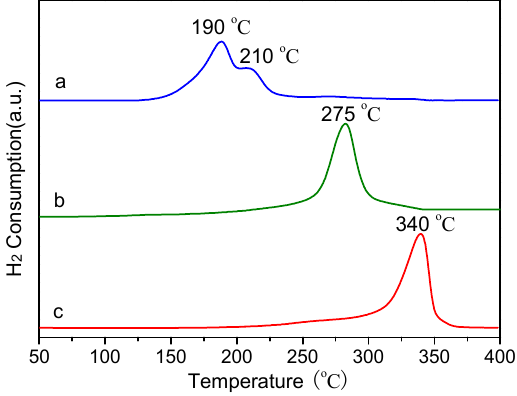
Figure 7. H 2 temperature ‐ programmed reduction (H 2 ‐ TPR) profiles of ( a ) Cu 2 O ‐ NO 3 , ( b ) Cu 2 O ‐ Cl(1) and ( c ) Cu 2 O ‐ Cl(2).